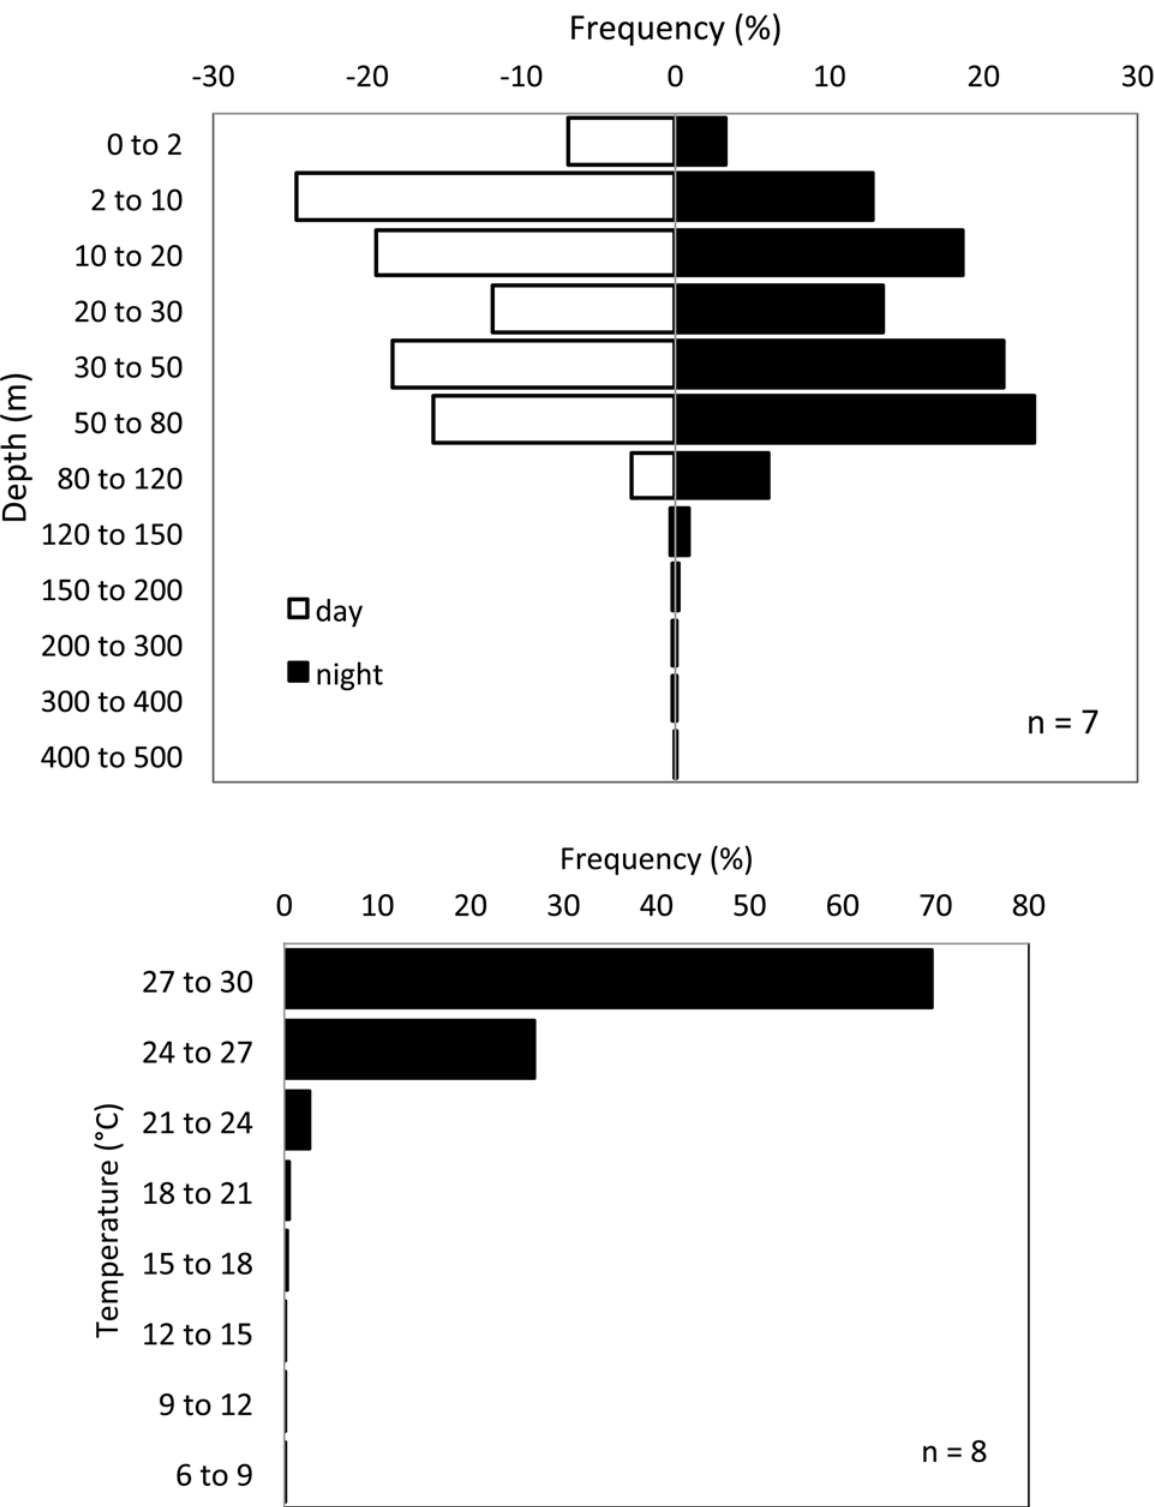
Fig 1. Depth and temperature preferences of oceanic whitetip sharks tagged in the western Atlantic Ocean between 2010 and 2012. Depth frequencies includes sharks OCS1 to 7 and temperature frequency includes data on all sharks.